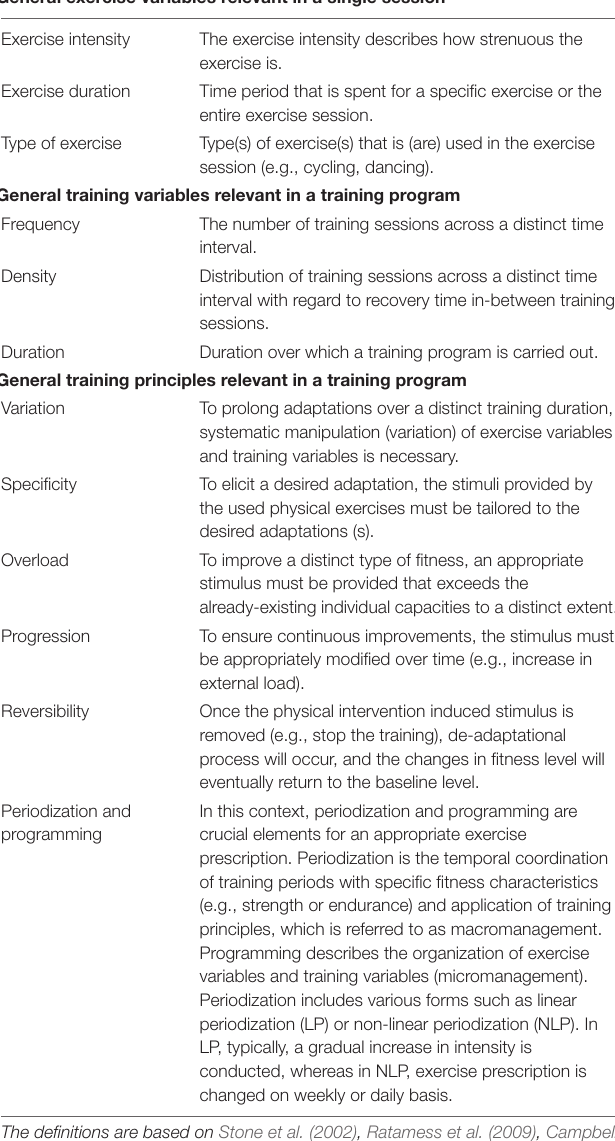
TABLE 2 | Overview of general exercise variables, training variables, and training